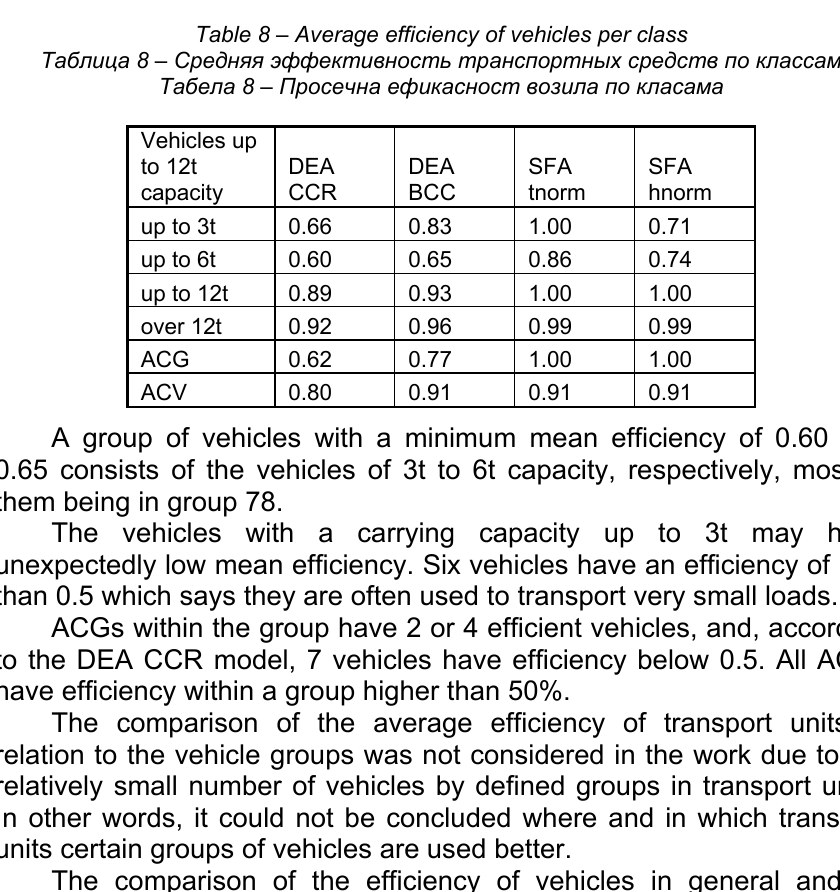
Table 8 – Average efficiency of vehicles per